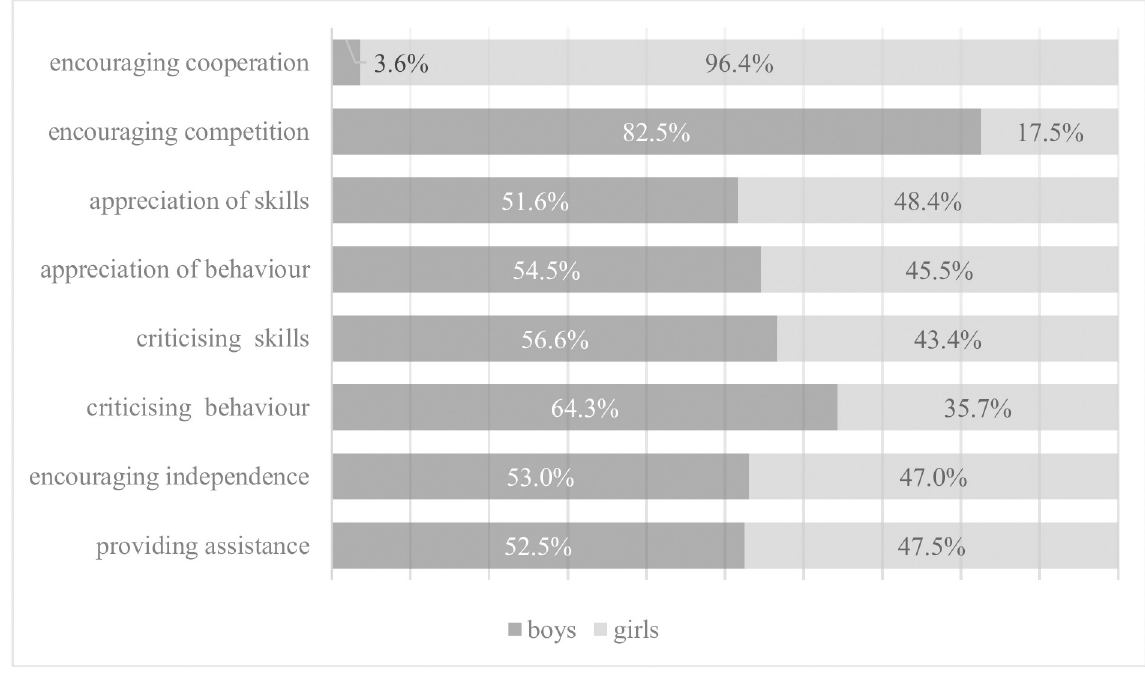
Fig 2. Distribution of the teachers’ message categories to male and female students.